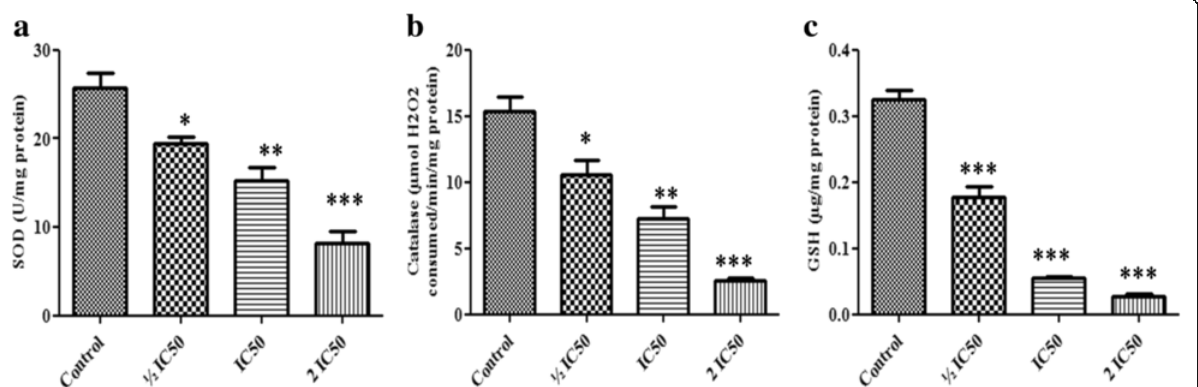
Fig. 9 Effect of F3 fraction on enzymatic ( a ) SOD, ( b ) catalase and non-enzymatic antioxidants status ( c ) glutathione (GSH) in NCI-H358 cells. The results are expressed as the mean ± SD of triplicate determinations, representative of three independent experiments. Significances indicated were in comparison to control (* p < 0.05; ** p < 0.01; *** p < 0.001 vs.